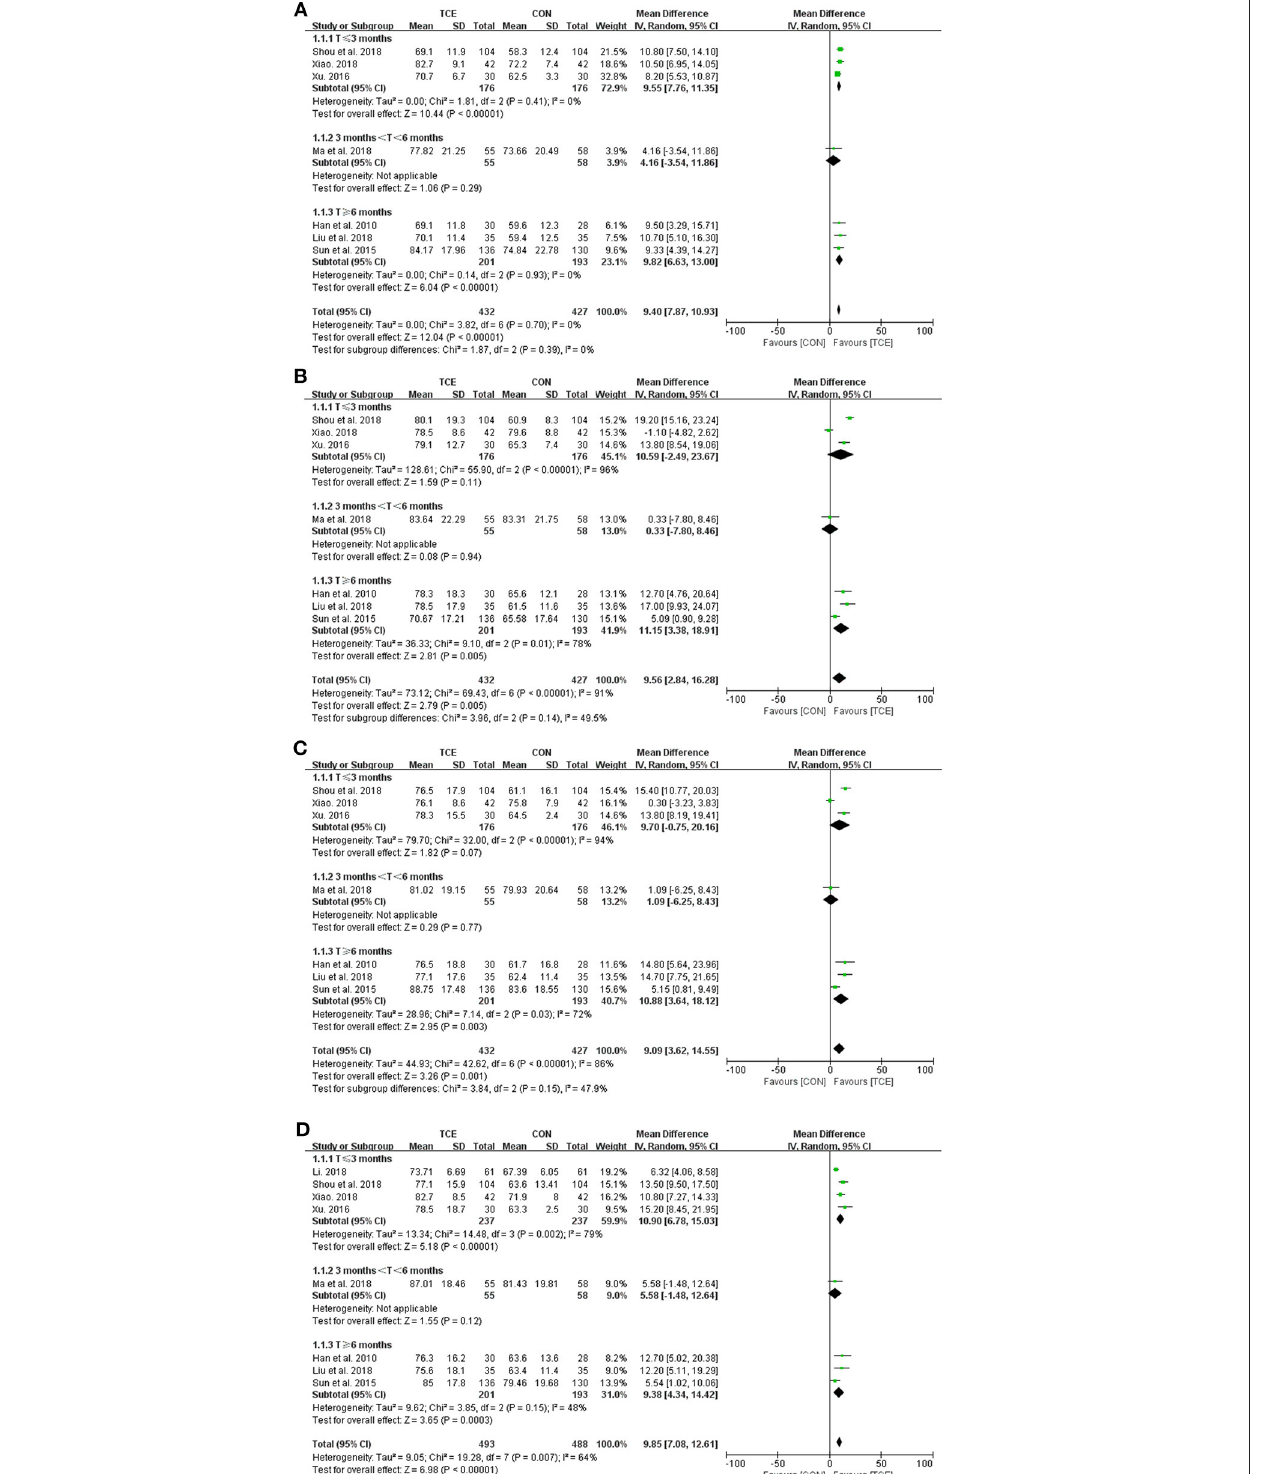
Frontiers in Cardiovascular Medicine |